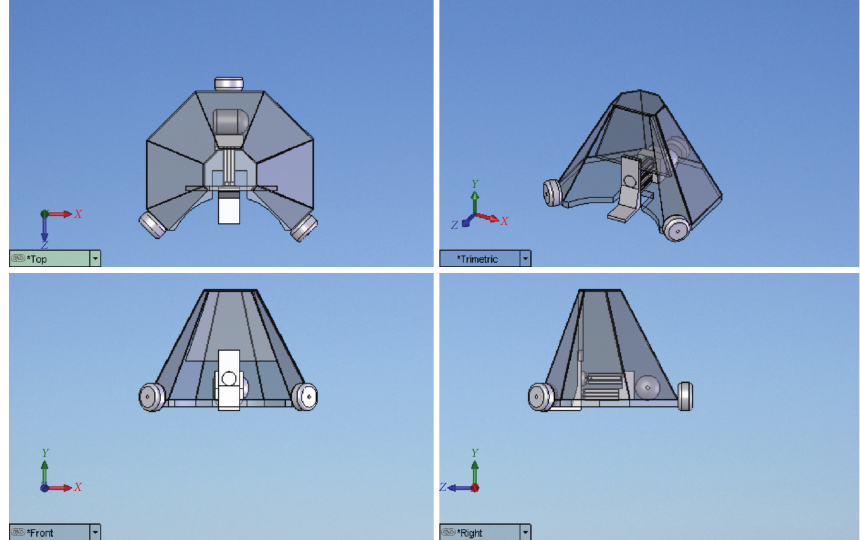
Figure 6: Conceptual design 5: Pyramid of three wheels with a lift kicker.